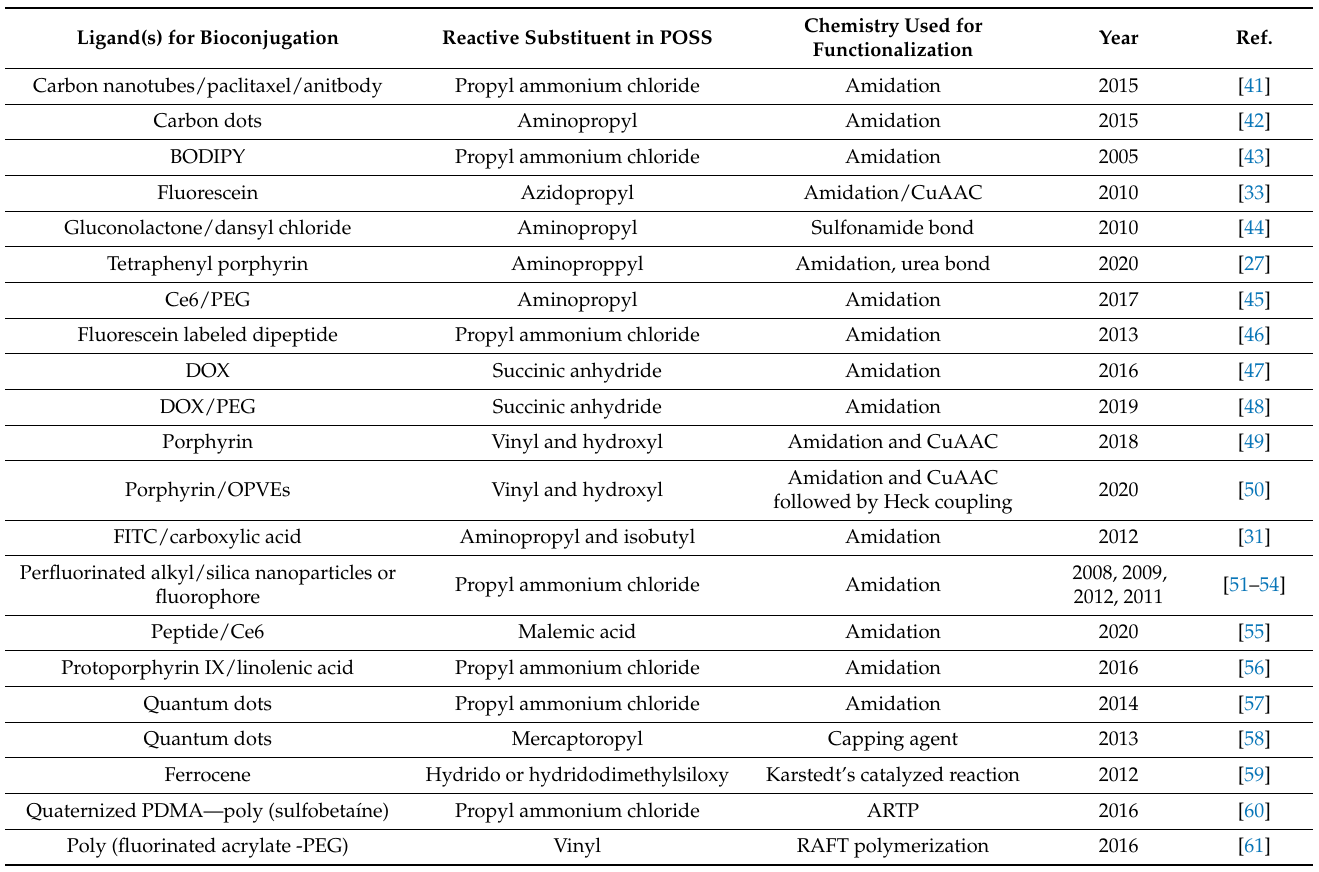
Table 1. Different synthetic approaches have been used to modify POSS for biomedical applications. Ligand(s) for Bioconjugation Reactive Substituent in POSS